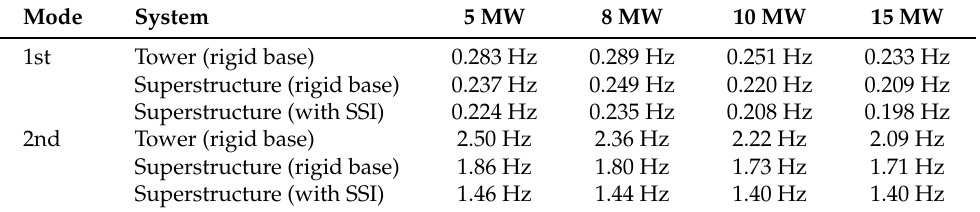
Table 4. Natural frequencies of the tower and superstructure obtained from the foundation design.